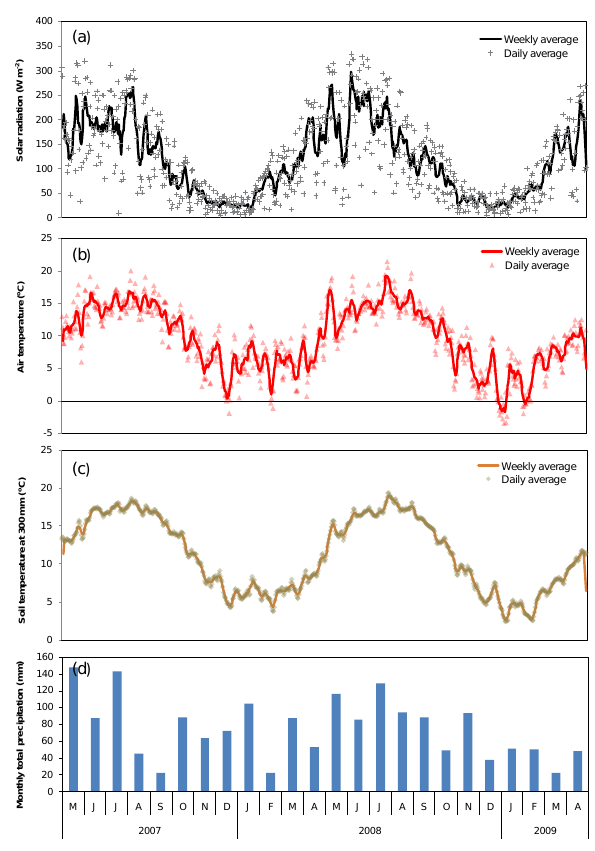
Fig. 3. Variation of (a) solar radiation; (b) air temperature; (c) soil temperature at 300mm depth; (d) monthly total precipitation over the study